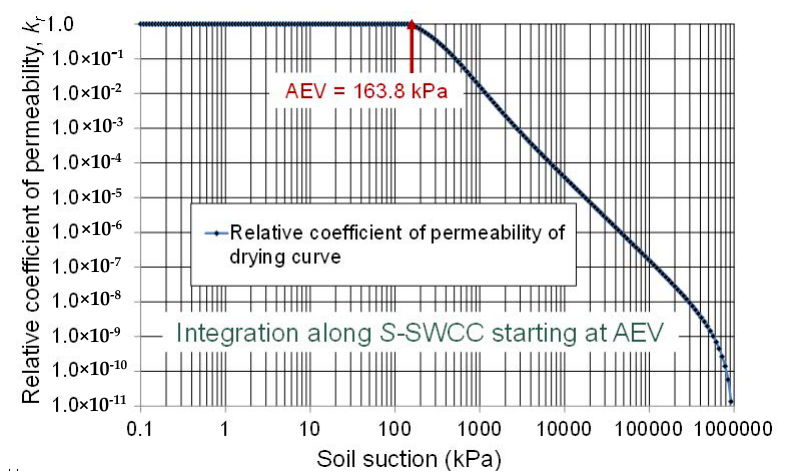
Figure 20. Calculated data points along the Fredlund et al. [25] permeability function calculated using a spreadsheet solution by Zhai and Rahardjo [24].